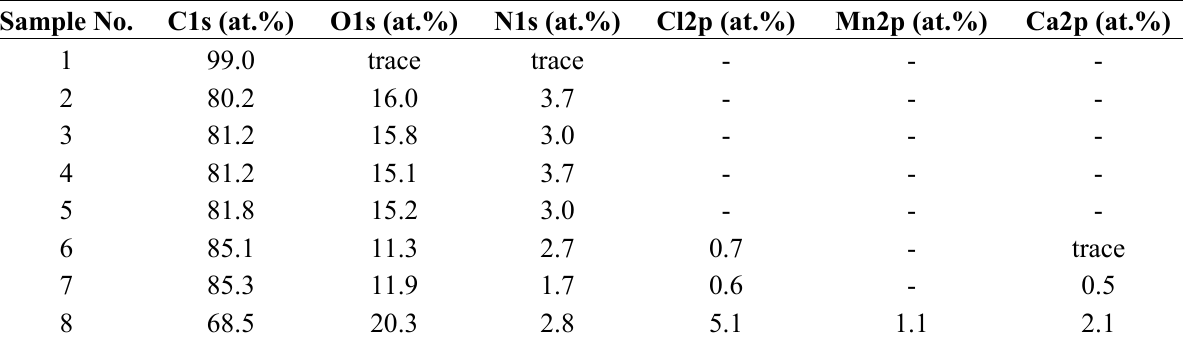
Table 2. Elemental composition of untreated and modified substrate surfaces calculated from respective X-ray photoelectron spectroscopy (XPS) survey spectra (experimental absolute error is ±0.5